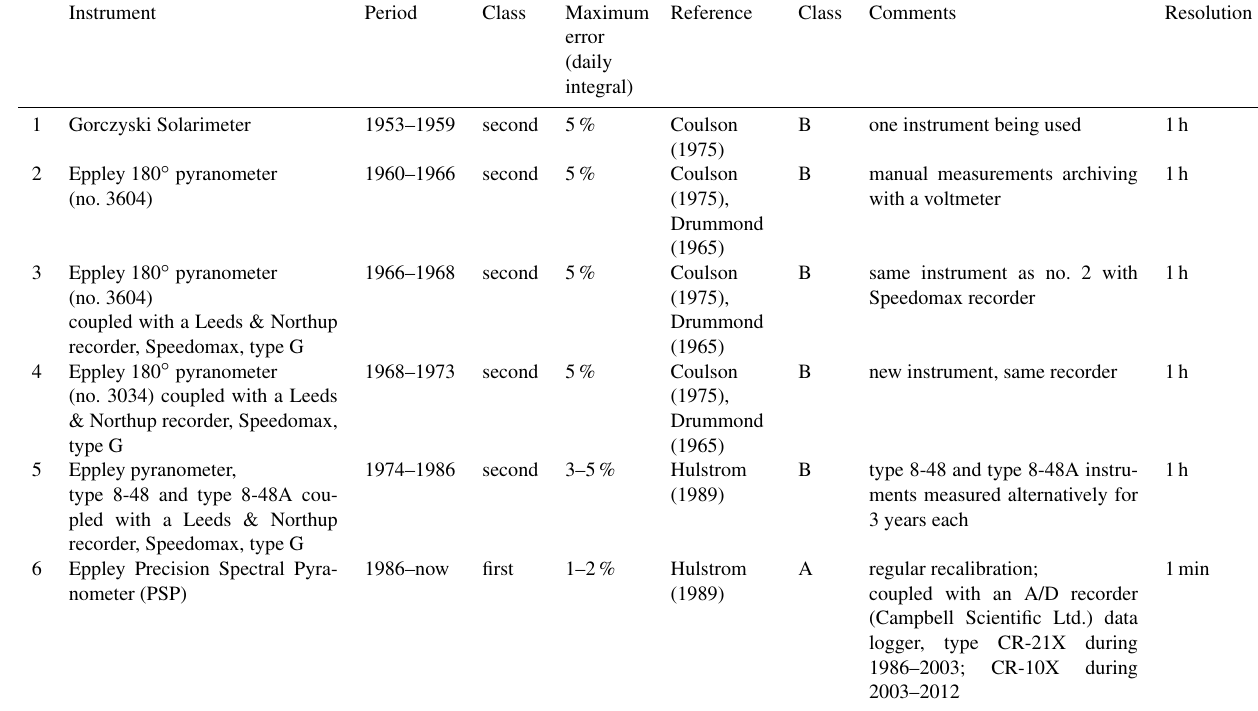
Table 1. History of SSR instruments used at ASNOA. SSR measurements refer to the total solar radiation on a horizontal surface.